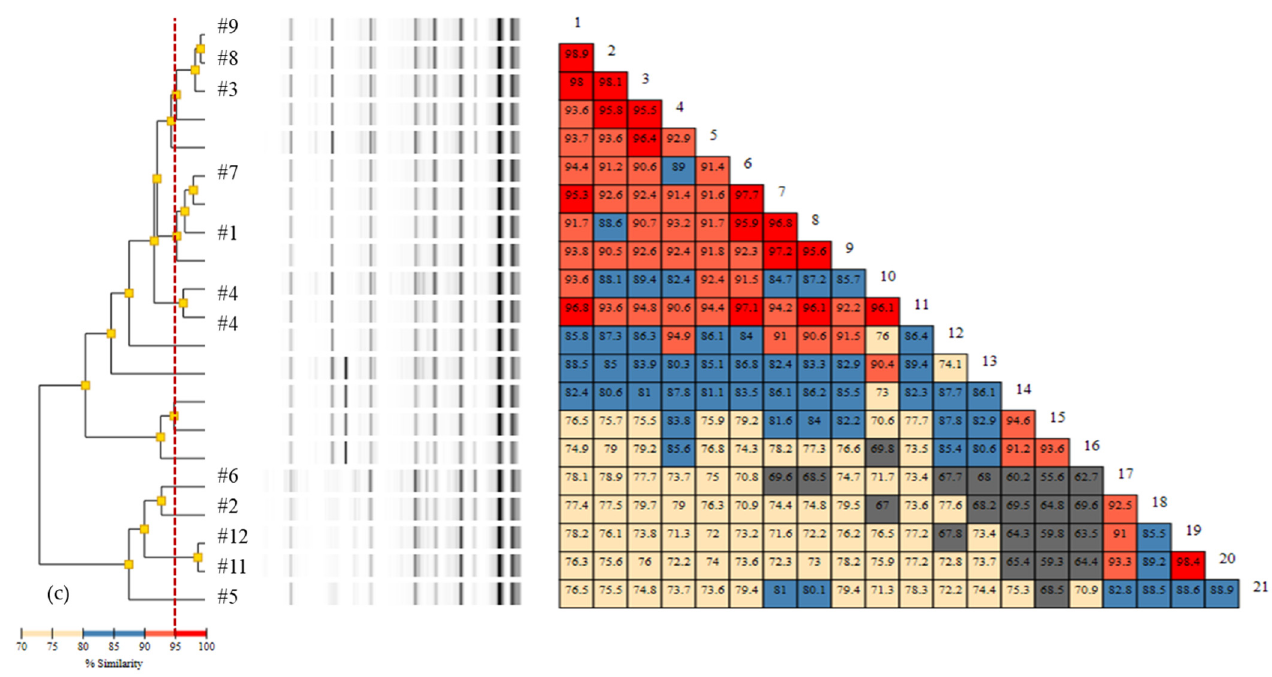
Figure 3. Repetitive element-PCR results by: ( a ) Pearson correlation; ( b ) Kullback–Leiber; and ( c ) extended Jaccard method.